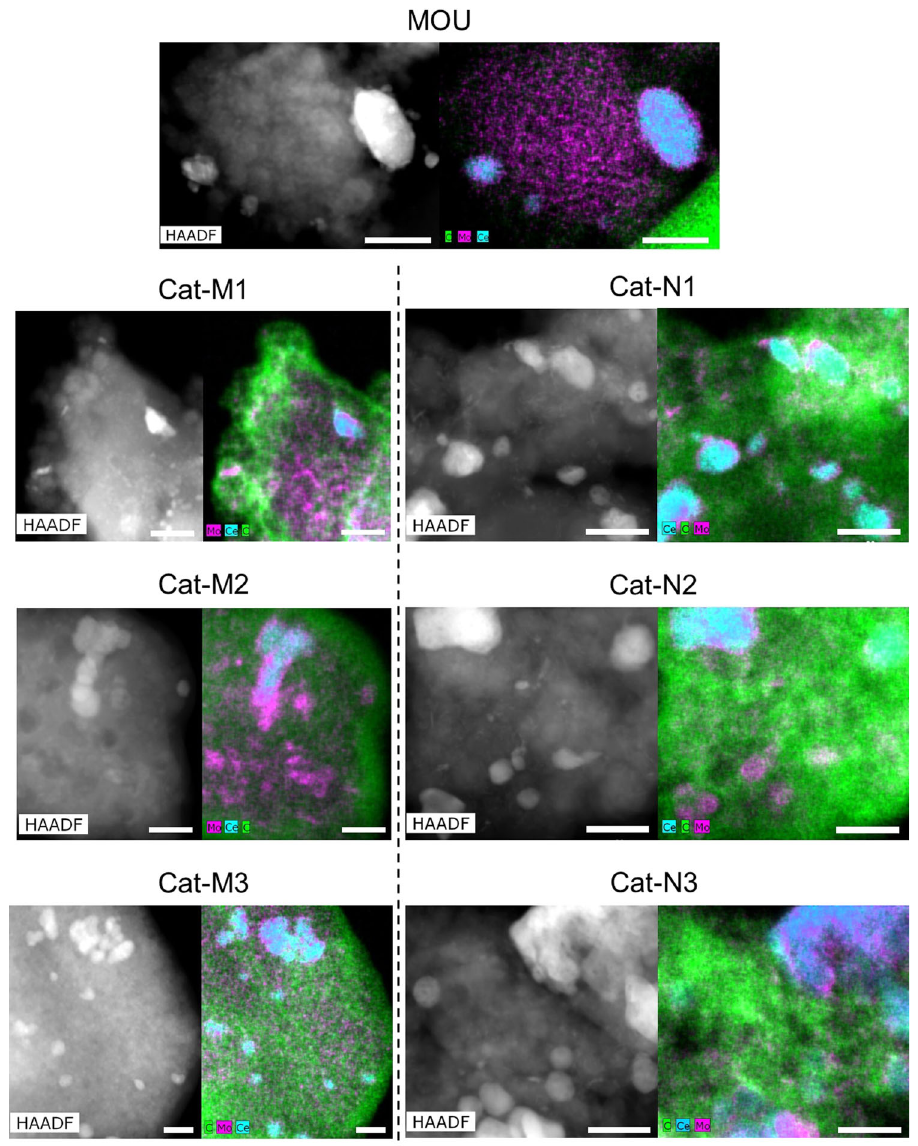
Fig. 3 HAADF-STEM images and EDX mapping results of fresh and used catalysts with different reaction cycles under methane and nitrogen. Colors of elements: green for carbon, cyan for cerium, and magenta for molybdenum. All scale bars represent the length of 40 nm.